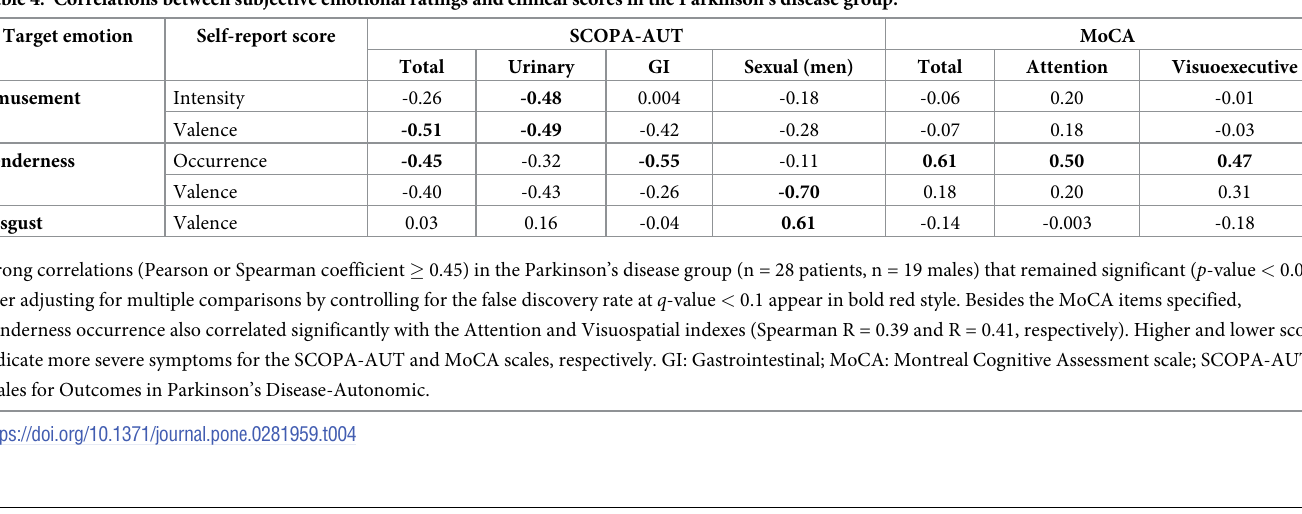
Table 4. Correlations between subjective emotional ratings and clinical scores in the Parkinson’s disease group.